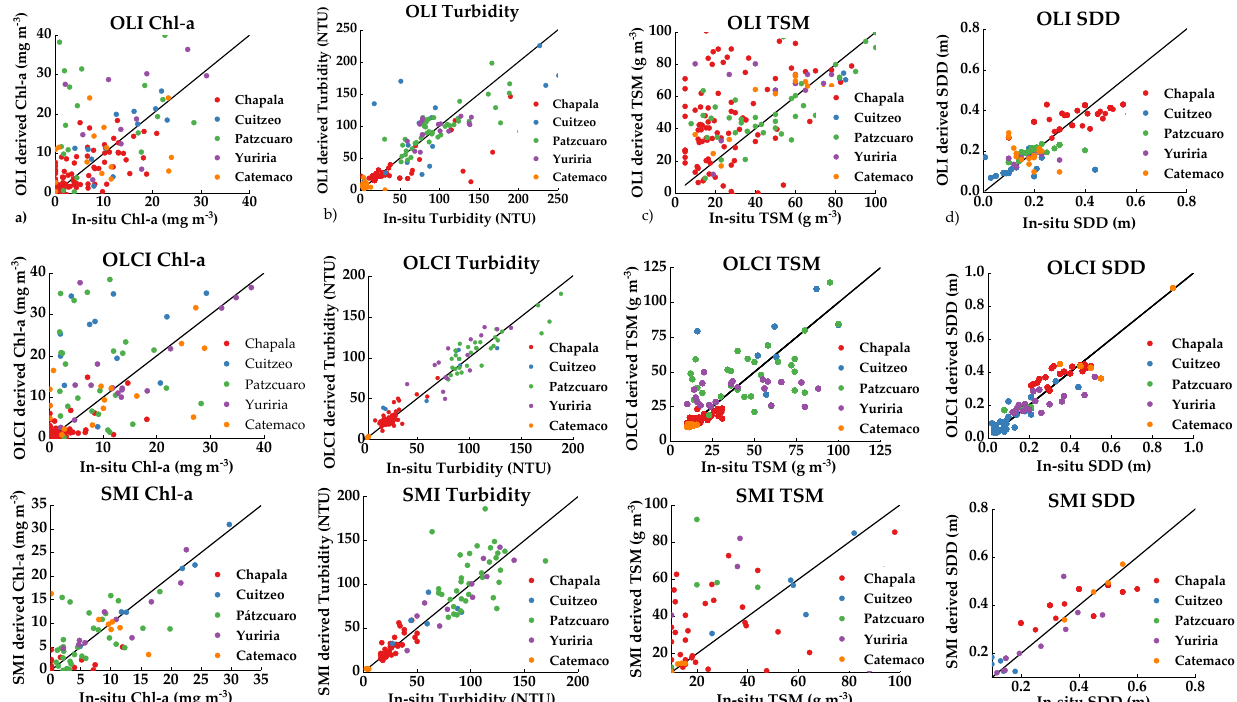
Table 4. Model occurrence in every sensor as a result of better predictive capabilities.